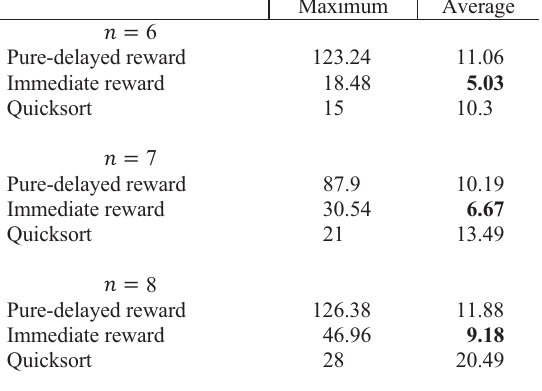
Table 5. The performance comparison between two reward schemes and Quicksort for 50 experiments of different values of 𝑛 . From the aspect of average performance, the immediate reward approach achieves the best results which are highlighted in bold